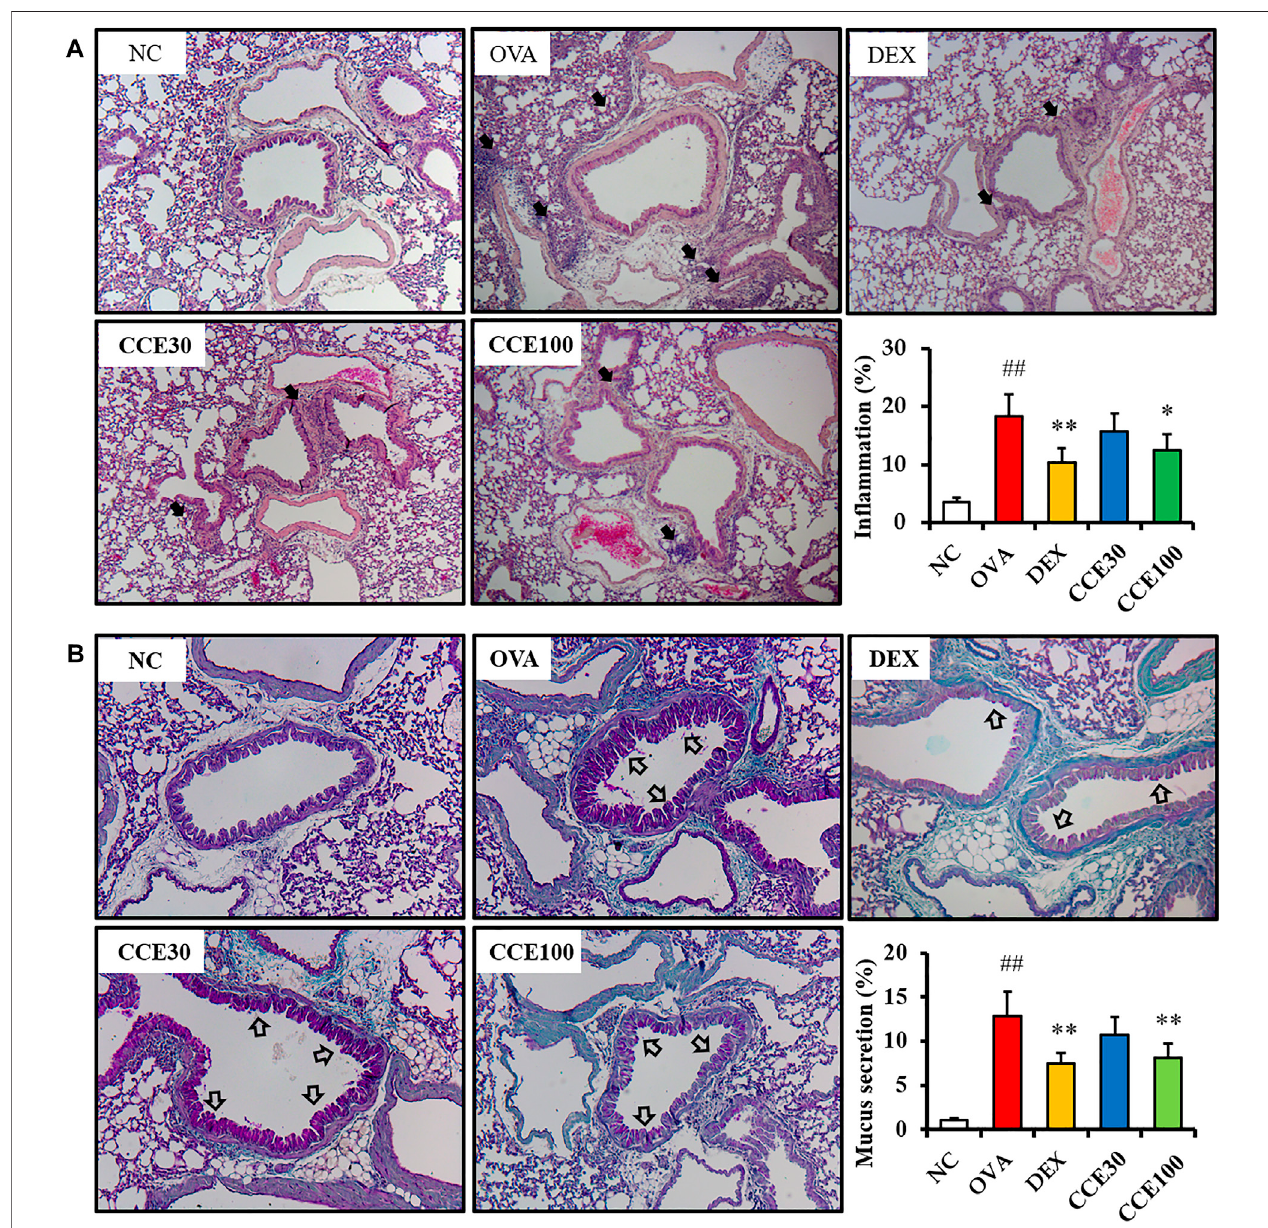
FIGURE 5 | CCE inhibited in fl ammatory responses and mucus production in OVA-exposed mice. (A) Representative fi gure and quanti fi cation for airway in fl ammation, (B) representative fi gureandquanti fi cation formucussecretion.Blackarrowsindicatedin fl ammatory cellaccumulationandblankarrows indicatedmucus secretion.NC,nonasthmaandPBStreatment;OVA,asthmaandPBStreatment;DEX,asthmaanddexamethasonetreatment;CCE30andCCE100,asthmaandCCE treatment (30 mg/kg and 100 mg/kg, respectively). ## p < 0.01, vs . NC; *,** p < 0.05 and < 0.01 vs . OVA, respectively ( n = 7 per group).